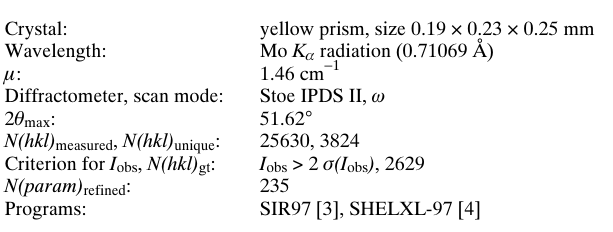
Table 1. Data collection and handling.